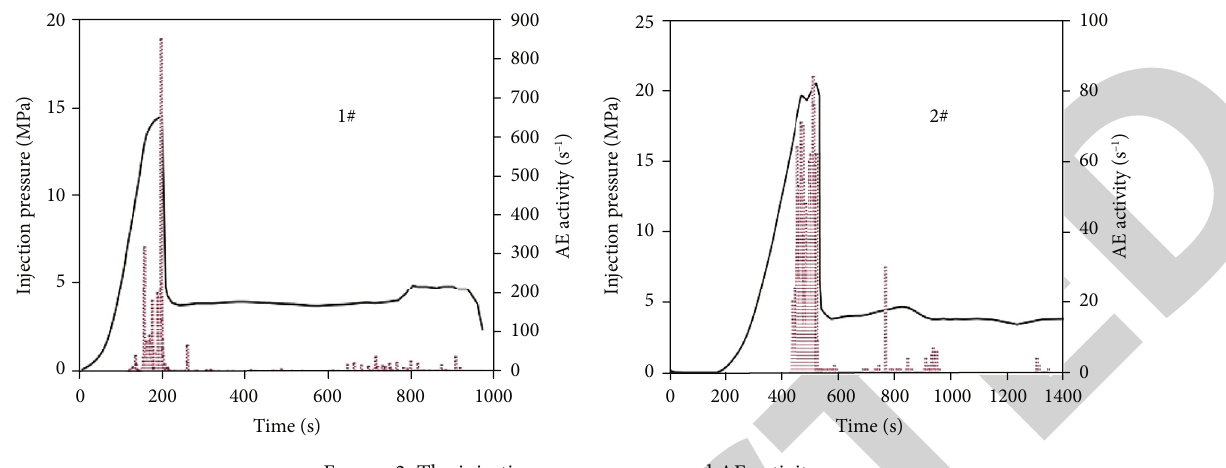
Figure 2: The injection pressure curve and AE activity.